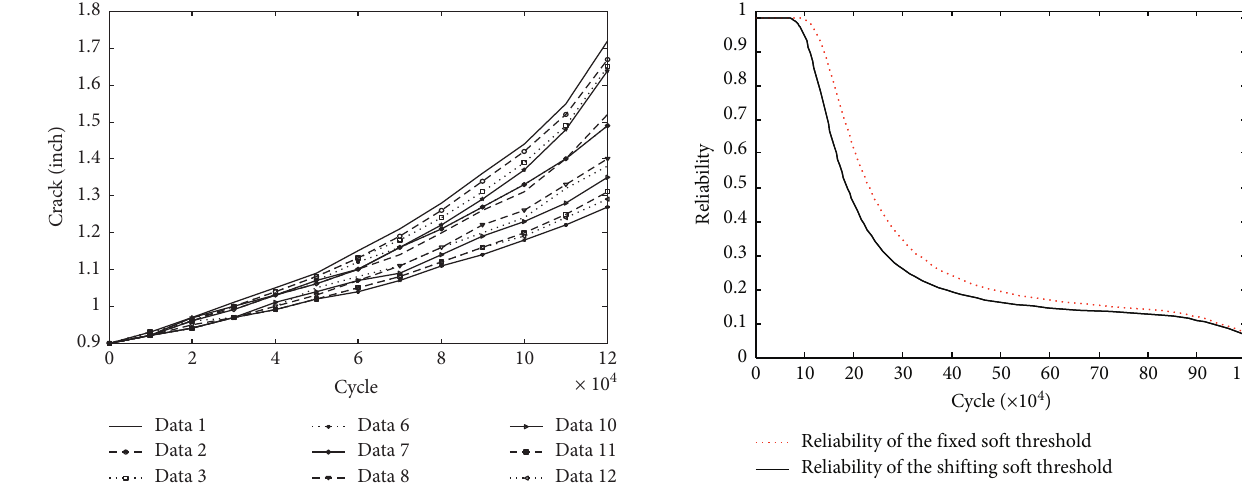
Figure 5: Reliability curves subject to soft failure.